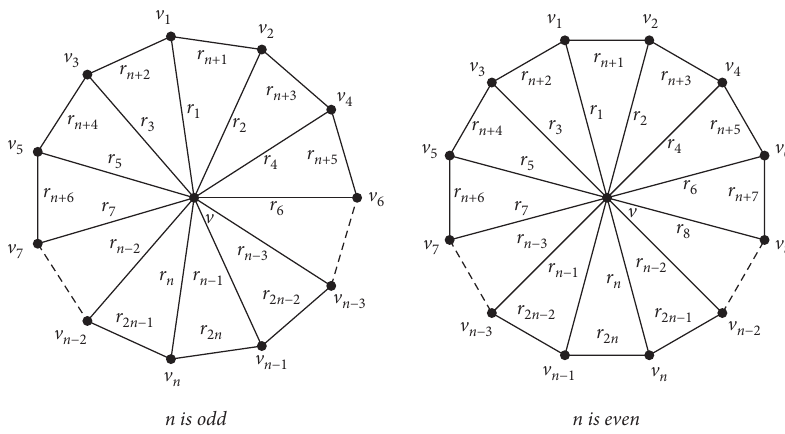
r + r r + r + · · · + r n if n − 1 n < n + 1 n + 2